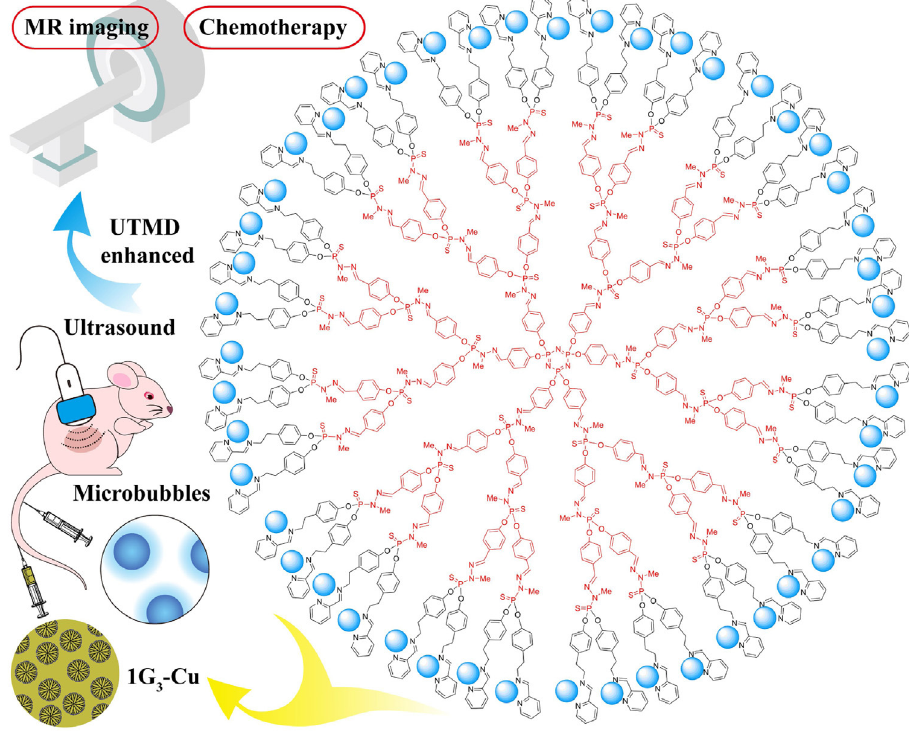
Figure 3. Schematic depiction of 1G3-Cu to take down SW1990 tumors using the UTMD-enhanced MR imaging strategy. Reproduced with permission from reference [38], Elsevier. MR imaging strategy. Reproduced with permission from reference [38],